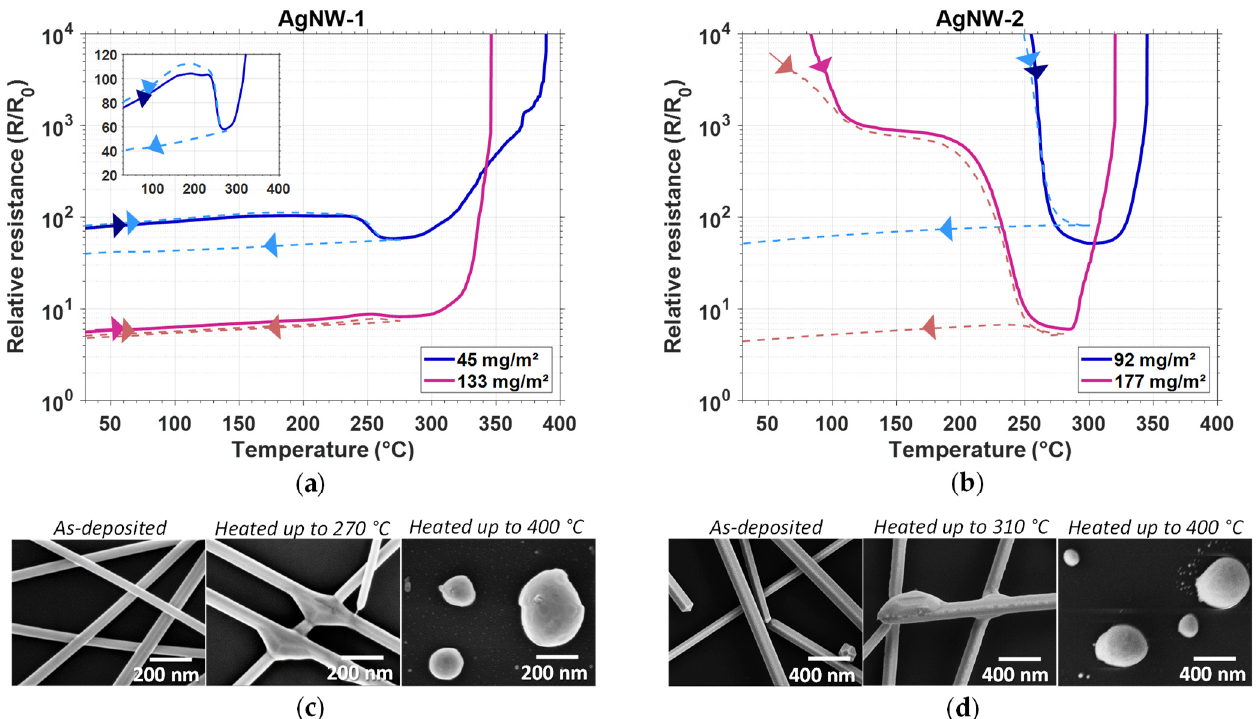
Figure 3. Effects of thermal treatment on AgNW’s electrical and structural properties for AgNW-1 and AgNW-2. Evolution in air of in situ electrical resistance of AgNW networks during a thermal ramp of 5 °C/min (solid line) ( a ) for AgNW-1 and ( b ) AgNW-2. Another specimen with a similar amd was thermally treated with the same thermal ramp (up to the temperature associated with the minimum electrical resistance (i.e., 270 °C and 310 °C for AgNW-1 and AgNW-2, respectively) and then cooled down to room temperature (dashed curve). The insert shows the linear dependence of both in situ resistance and temperature, according to Equation (4). SEM observations show the morphological change before (as-deposited) and after thermal treatment up to different temperatures for ( c ) AgNW-1 and ( d ) AgNW-2.